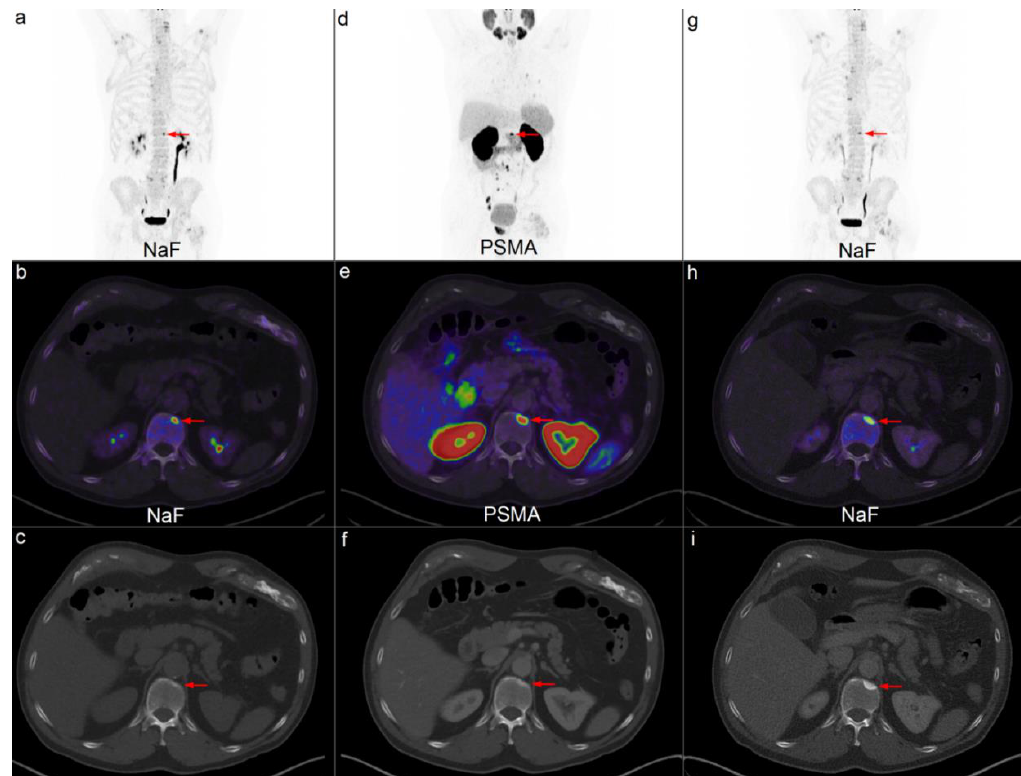
Figure 1. Example of a patient referred for 18 F-NaF PET / low-dose CT (ldCT) for primary staging. An inconclusive lesion ( red arrow ) with increased uptake on 18 F-NaF PET / ldCT is noticed in Th12 on maximum intensity projection (MIP) ( a ) and in fused axial projection ( b ). No correlating lesion is observed on ldCT ( c ). Subsequent 68 Ga-PSMA PET / CT showed increased uptake ( d , e ). Nevertheless, there was no visible lesion on CT ( f ). Five months later, an additional 18 F-NaF PET / CT scan showed increased uptake ( g , h ). A sclerotic lesion was visible on CT by that time ( i ). Several lymph node metastases and lung metastases are noticed on the PSMA MIP ( d